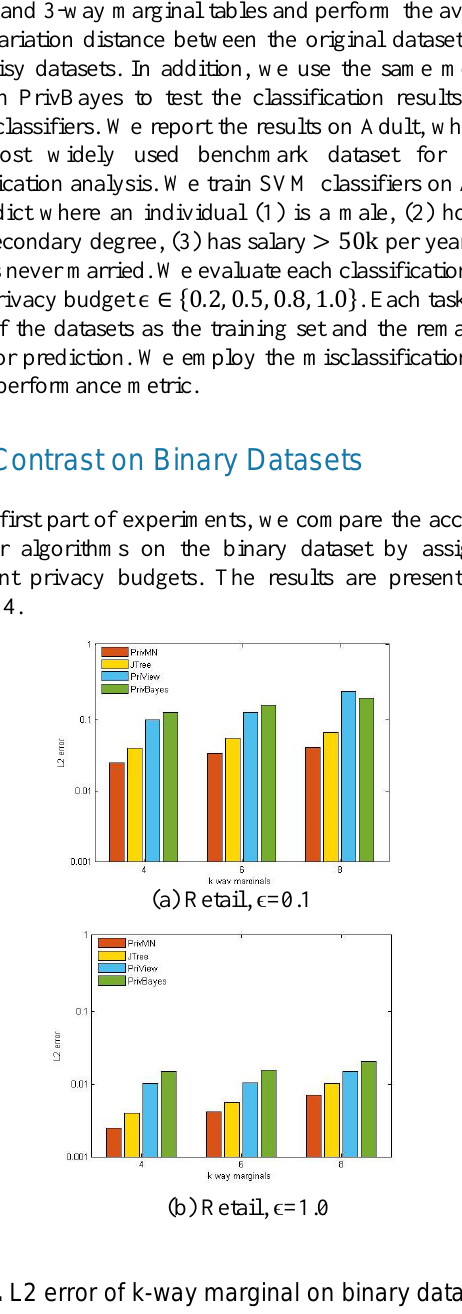
Fig.4. L2 error of k-way marginal on binary